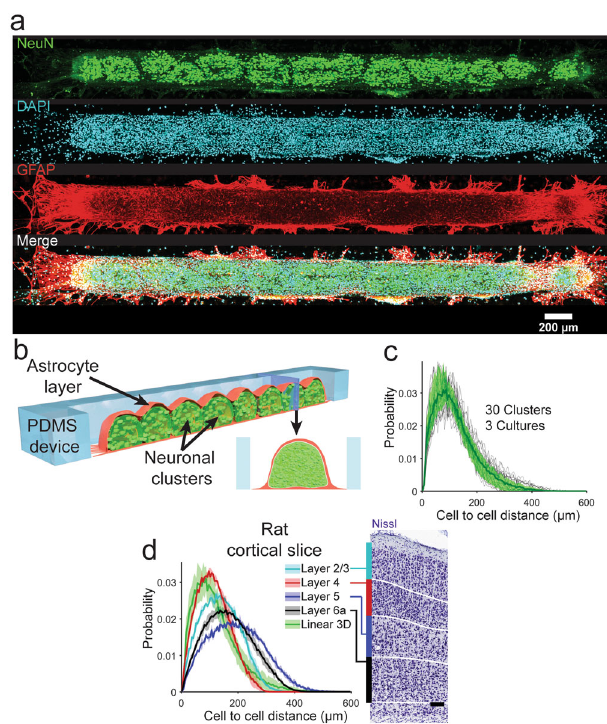
Fig. 2 Immunohistochemistry analysis of linear 3D culture and comparison with rat cortical section. a Projection of brightest point of image stack of linear 3D culture, fi xed on DIV 14, co-stained with (from top to bottom) NeuN (green), DAPI (cyan), and GFAP (red). Bottom row shows merged image. b Representation (not drawn to scale) of linear 3D culture shows neuronal clusters and super fi cial astrocyte layer. (Red: astrocytic layer, Green: Neuronal layer) c Cell to cell distance pro fi le (CCDP) counted from NeuN + cells of 30 clusters from three cultures (11, 8, and 11 clusters). Thin black lines show CCDP of individual clusters, thick green line indicates the mean CCDP of all clusters with standard deviation indicated by green shaded area. d CCDPs calculated from different layers of Nissl stained rat cortical slices from PND 08 rat on the left, Nissl stained image and layer labels on the right, image courtesy: BrainMaps: An Interactive Multiresolution Brain Atlas; http://brainmaps.org. Thick line for each layer (color indicated in legend) shows mean of CCDPs from six regions of interests (ROI) from three z -positions (one from each hemisphere of each z -position) while shaded area of same color indicates the standard deviation. CCPD for linear 3D cultures is included for comparison. Scale bar: 100 μ m for d